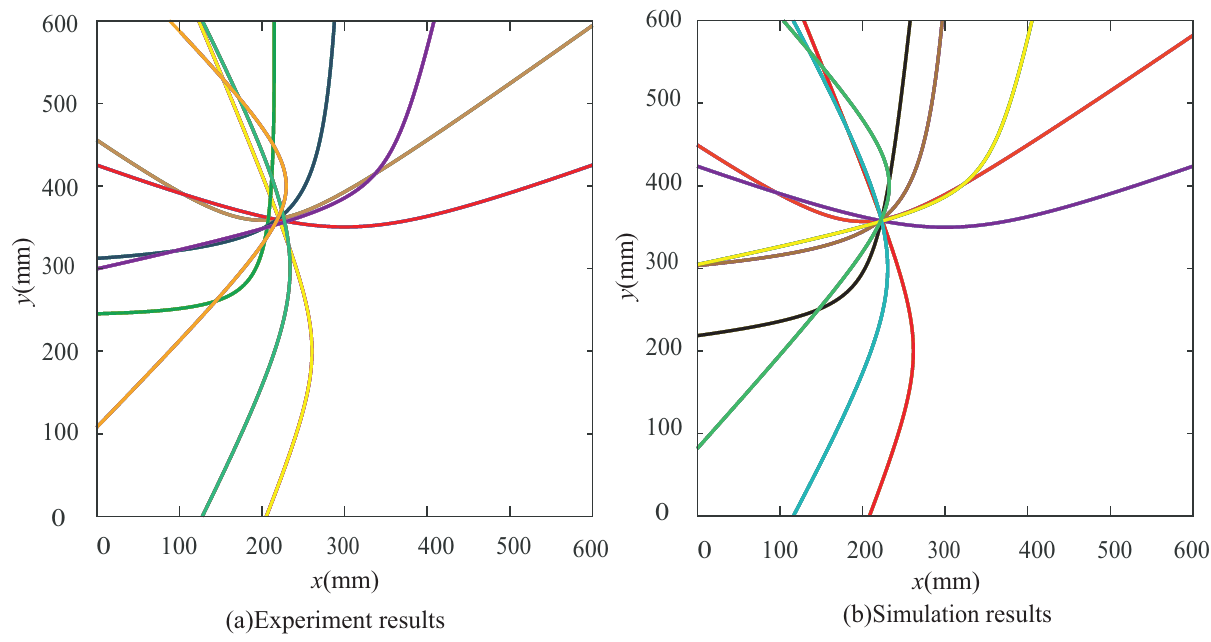
Figure 20. Hyperbolas of two groups of 4 sensors under Case I: ( a ) experiment and ( b ) simulation. As shown in Figure 20, a total of 32 intersections are obtained from the experimental hyperbola and 34 intersections are obtained from the numerical hyperbola. The coordinate values of the corresponding intersections are shown in Tables 8 and 9, respectively. These intersections can be used to obtain a new prediction of damage localization, as shown in Table 10. After the optimization of the layout, the absolute distance between the center of the predicted damage localization and the actual center is significantly reduced. The number of sensors was increased to eight. More hyperbolas can be obtained by using the received signals of all sensors. The prediction of damage localization through the intersection obtained by eight sensors is shown in Table